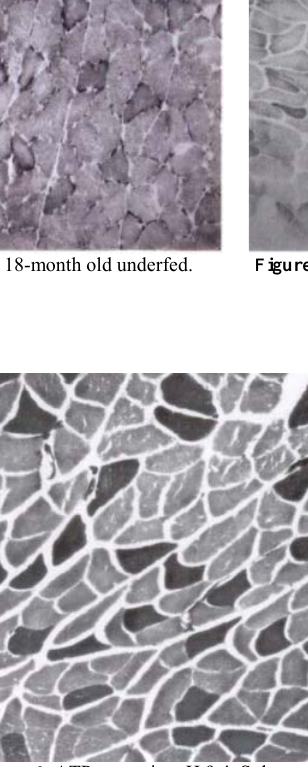
Figure 6. ATPase statin, pH 9.4, Soleus muscle, 10-month old